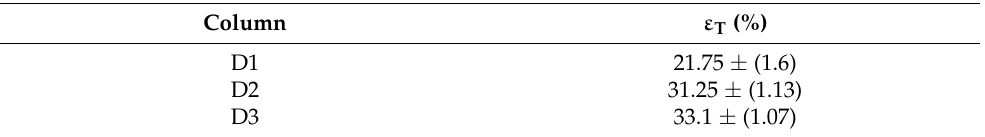
Table 1. Porosity and performance of the prepared polymer monoliths using uracil, mobile phase: methanol 100%, flow rate: 1 µ